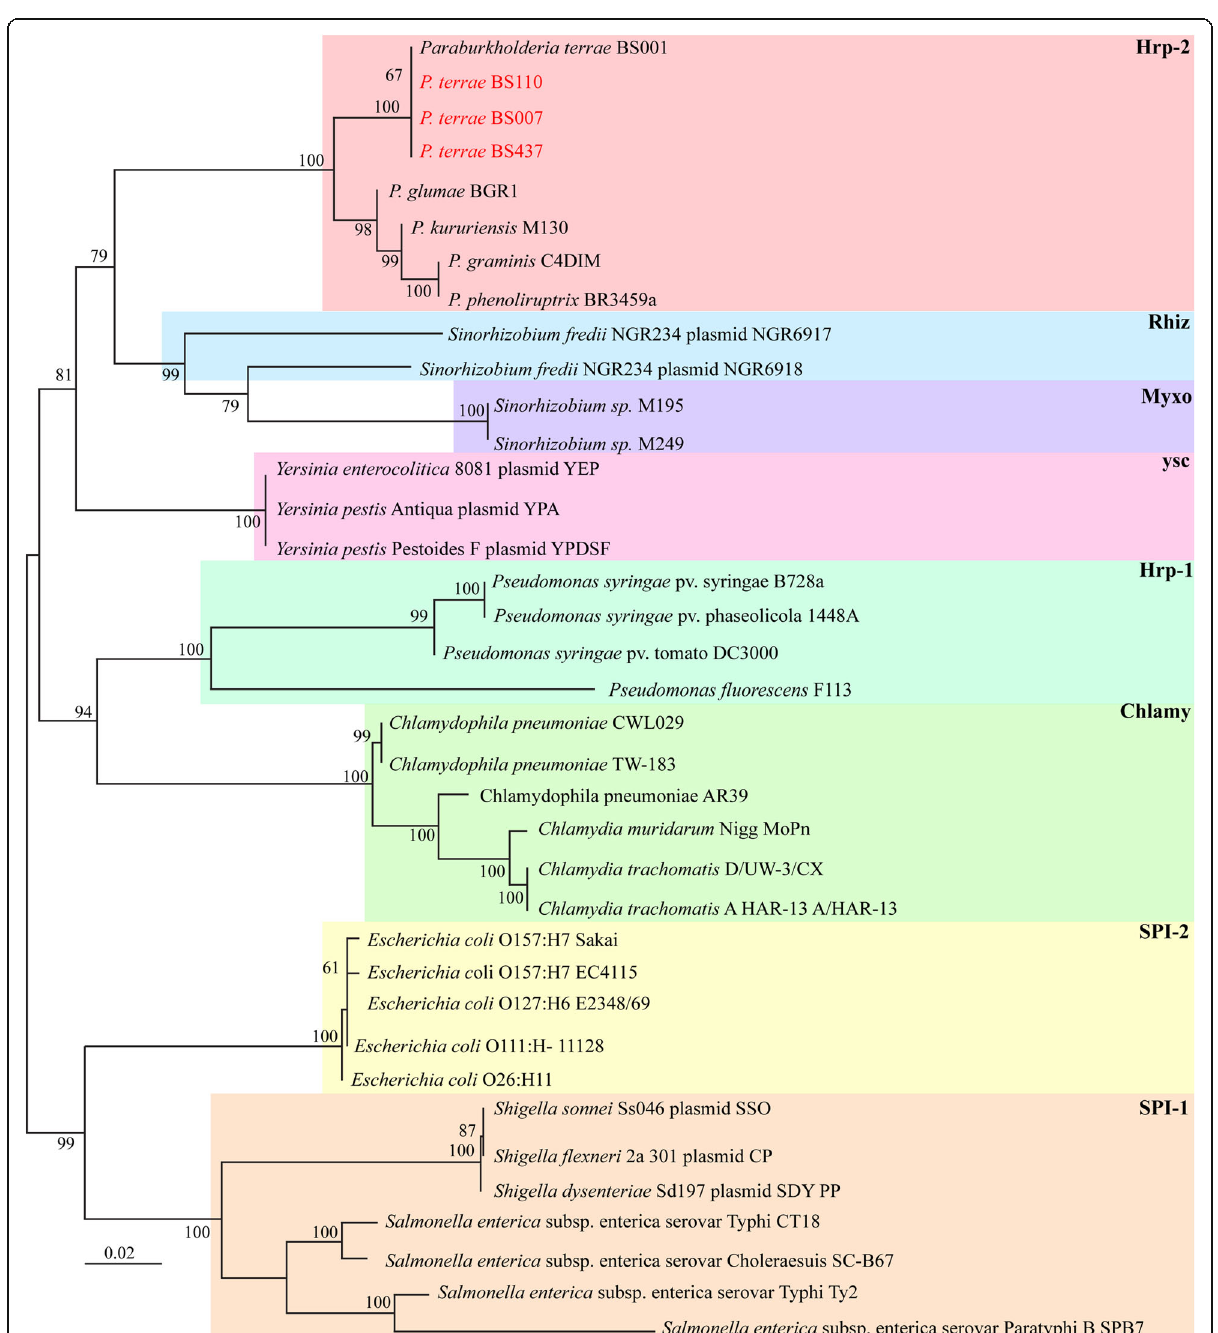
Fig. 5 Phylogenetic tree of selected type-3 secretion systems (T3SS). The tree was generated based on alignment of eight conserved genes of the T3SS ( SctS, SctR, SctQ, SctV, SctU, SctJ, SctN, and SctT ). Evolutionary distance was computed with MEGA7 using a maximum-likelihood method. The bootstrap values above 50% (from 1000 replicates) are indicated at the nodes. The T3SSs of P. terrae strains BS007, BS110 and BS437 T3SS belong to the Hrp-2 type, as previously reported for BS001 [8]. Different types of T3SSs were described in Abby and Rocha